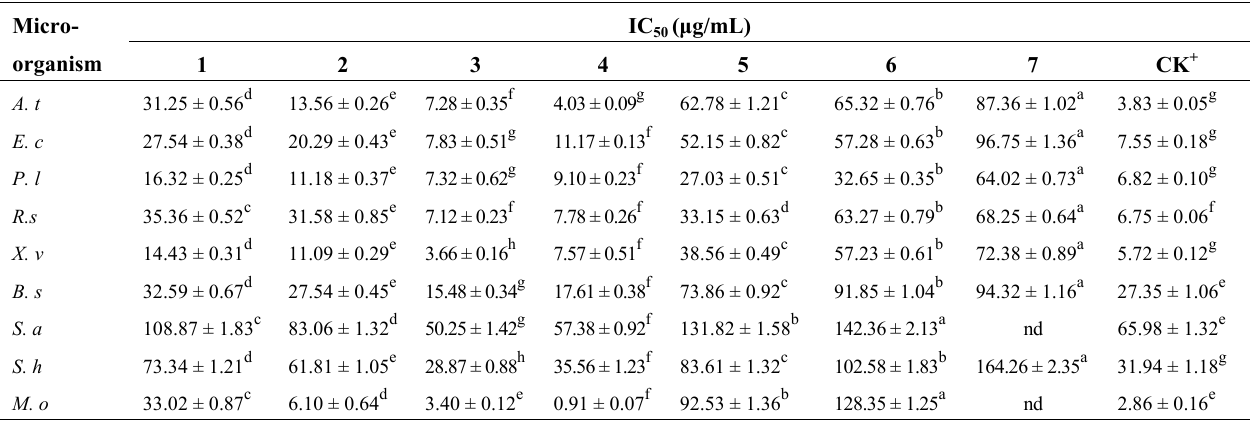
Table 2. IC values of the compounds 1 – 7 obtained from the cultured hairy roots of S. 50 miltiorrhiza on test microorganisms.